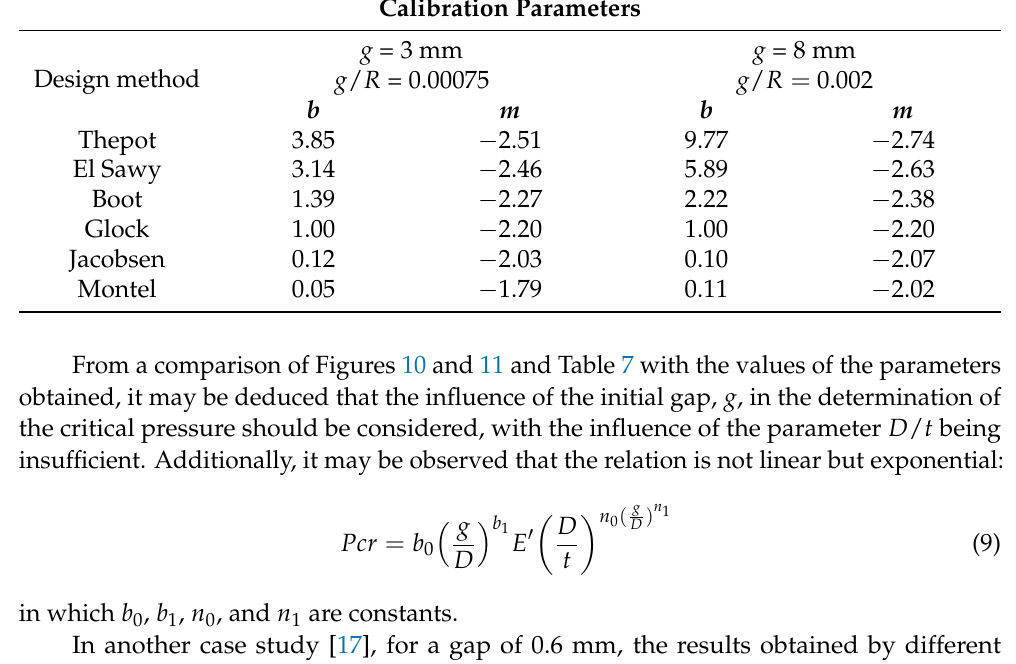
Table 7. Calibration parameters for different formulations. Calibration